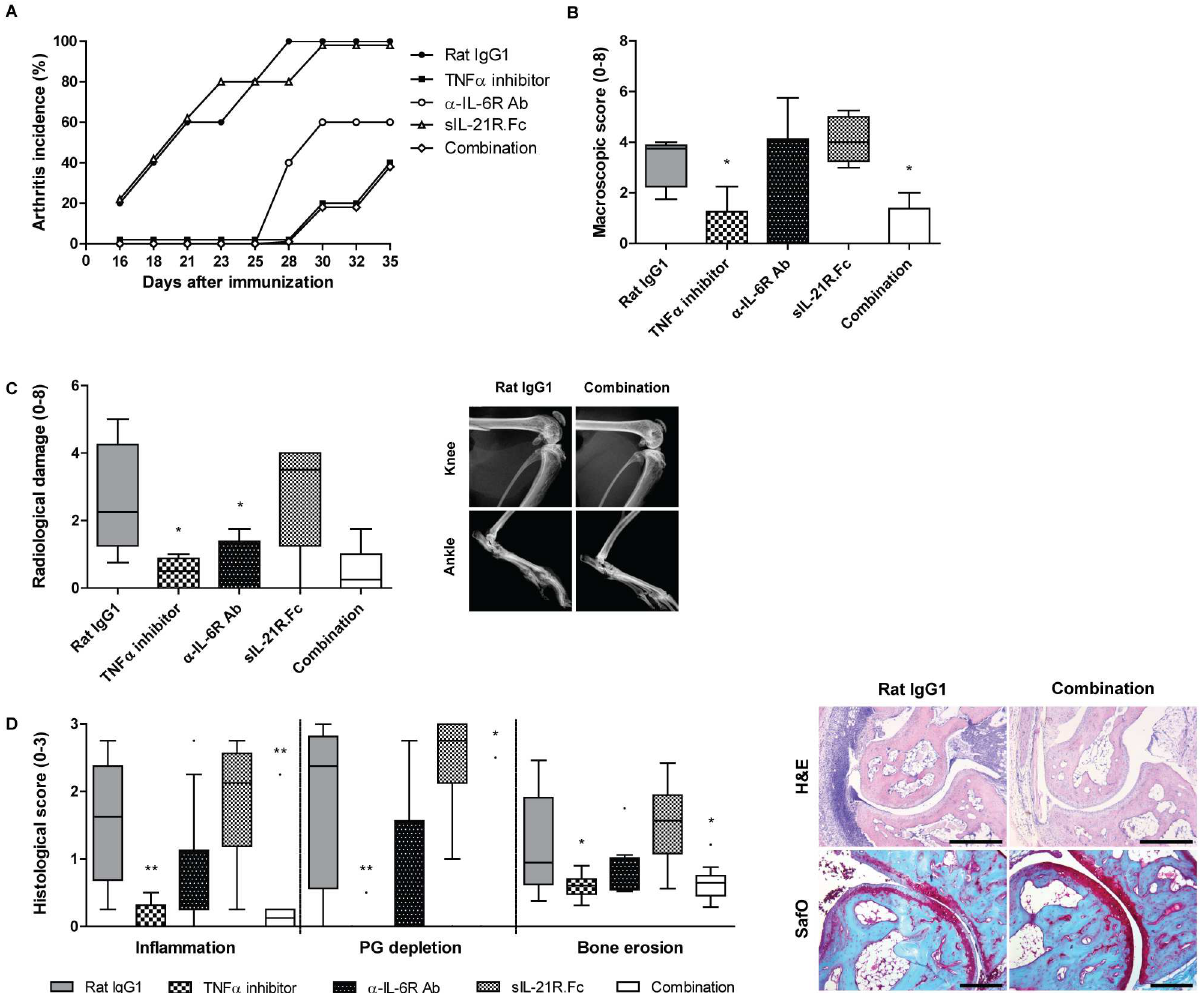
Fig 5. Arthritis incidence and severityof mice receiving anti-IL-6 and/or anti-IL-21 treatment during the induction phase of the disease. Collagen-inducedarthritis was initiated in DBA-1 mice, subsequently treated with anti-IL-6Rantibodiesand/or sIL-21R.Fc from the day of the immunization injection(d = 0; n = 5/group). Arthritis incidence(A) and severity (B) based on macroscopic scoring. Bone damage as measuredusing the Faxitron depictedas radiologicaldamage(C). Histologically scored inflammation, bone erosion (both H&E staining, scale bar 500 μ M), and cartilageproteoglycan depletion(SafO staining,scale bar 200 μ M) (D). * p < 0.05, ** p < 0.01versus Rat IgG1; One- way